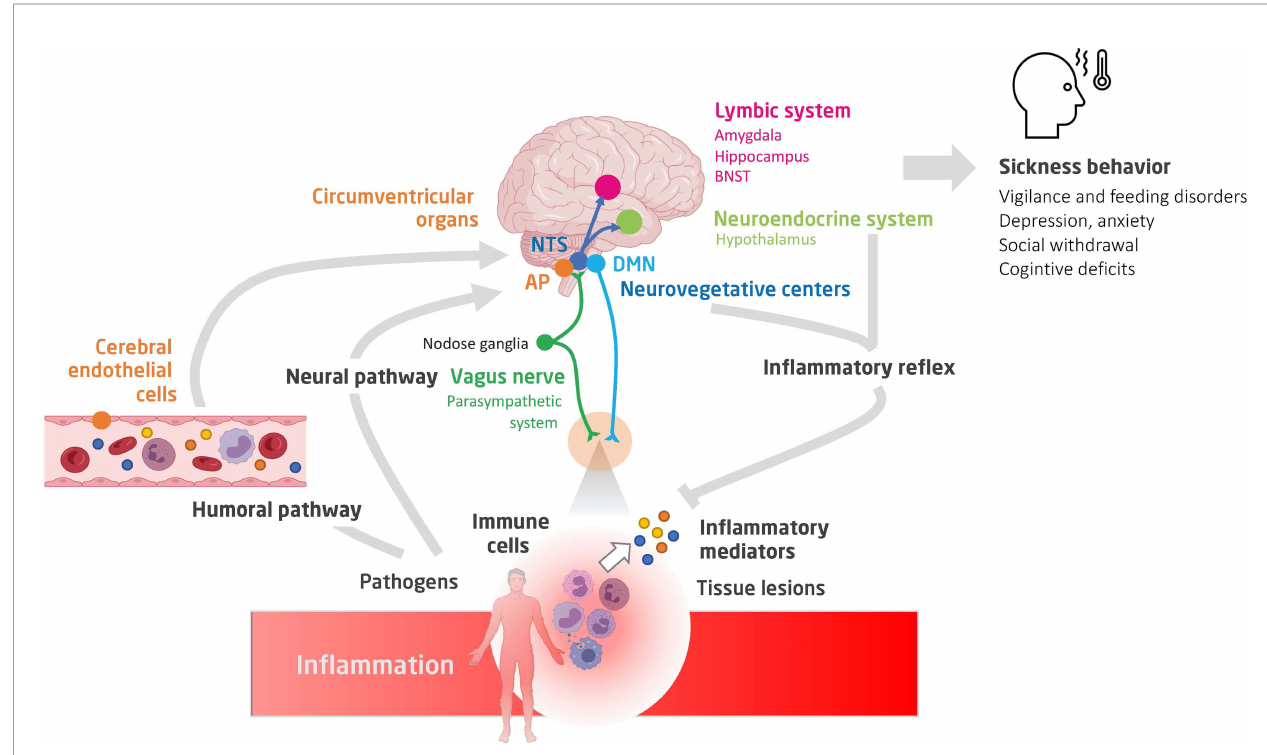
FIGURE 1 | A schematic view of the neuro-immune crosstalk during in fl ammation. Shown are the humoral and neural pathways conveying in fl ammatory signaling to the brain, the main brain centers involved in the integration of the in fl ammatory signaling and controlling autonomic, neuroendocrine and behavioural responses (constituting sickness behavior), and fi nally, the interaction between peripheral immune cells (notably of the spleen) and stress hormones and autonomic efferences (35, 36). NTS, nucleus of tractus solitarius; AP, area postrema; DMN, dorsal nucleus of vagus nerve; BNST, bed nucleus of the stria